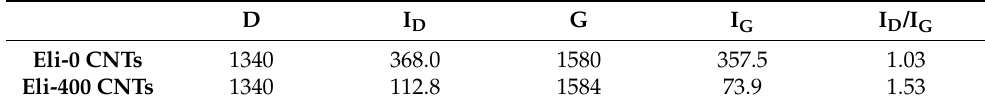
Table 2. Summarized results of Raman shifting.